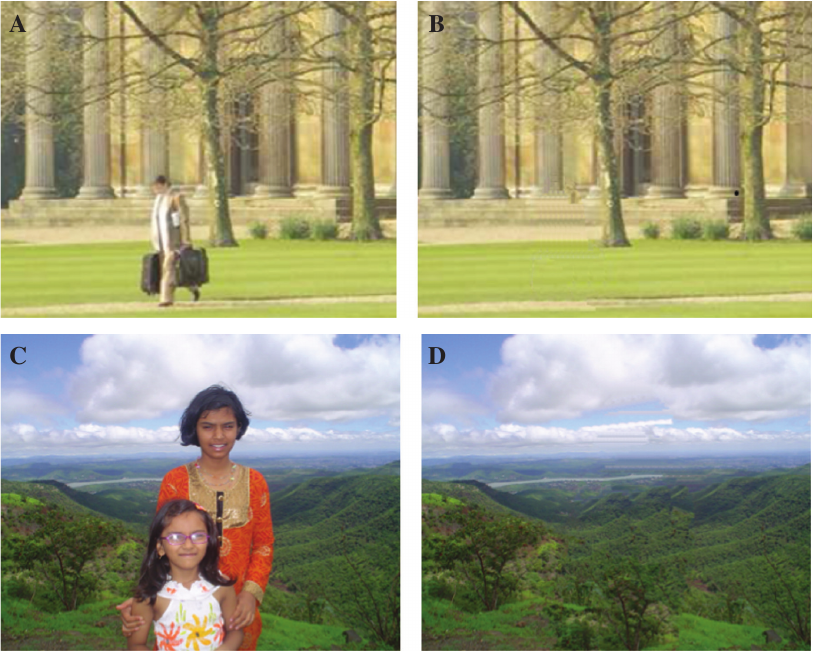
Figure 5. Large-Object Removal. (A, C) Original Photographs. (B, D) The Region Corresponding to the Foreground Person